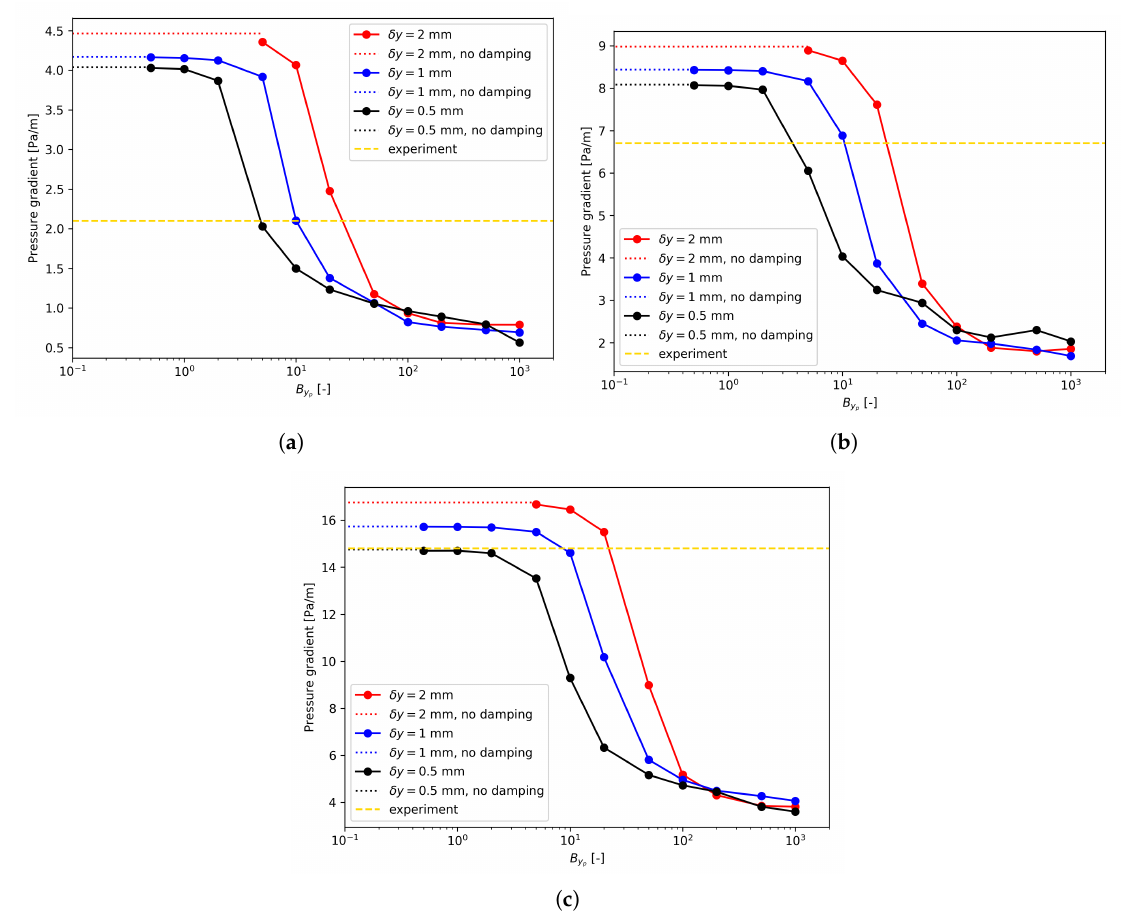
Figure 8. Pressure gradient dependency on B y